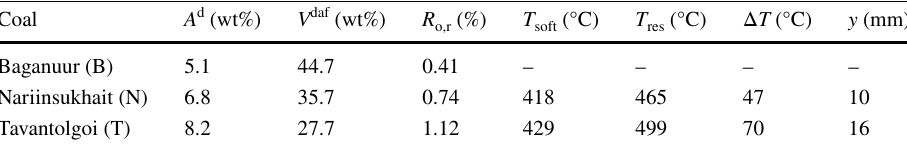
R o,r is random vitrinite reflectance; plasticity range; y is plastic